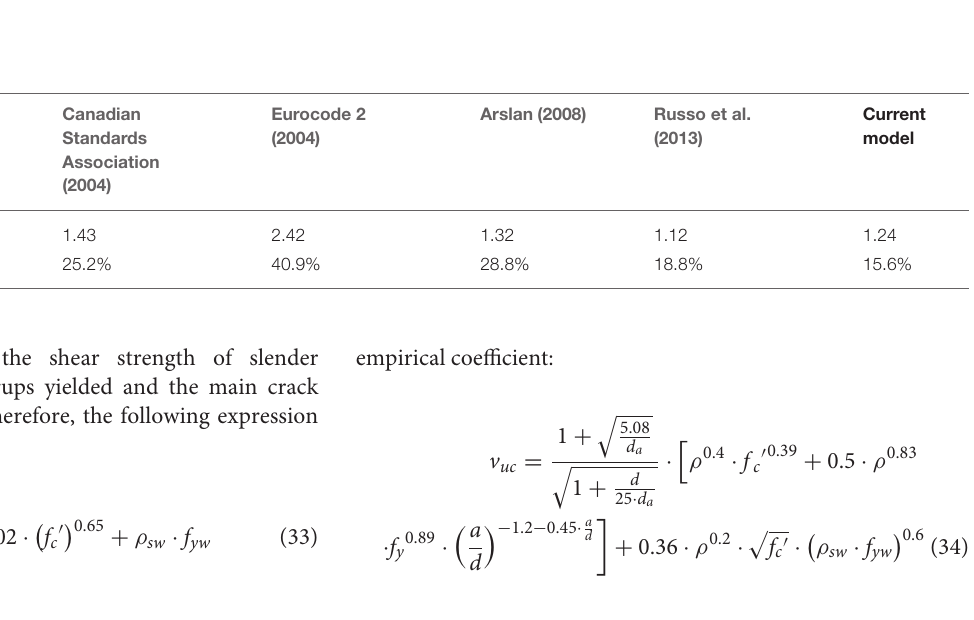
FIGURE 7 | Variation of the ratio between experimental and analytical shear stress according to: (A) (ACI Committee 318, 2008) (B) (Canadian Standards Association, 2004) (C) Eurocode 2 (2004), (D) Russo et al. (2013); (E) Arslan (2008); (F) proposed model.